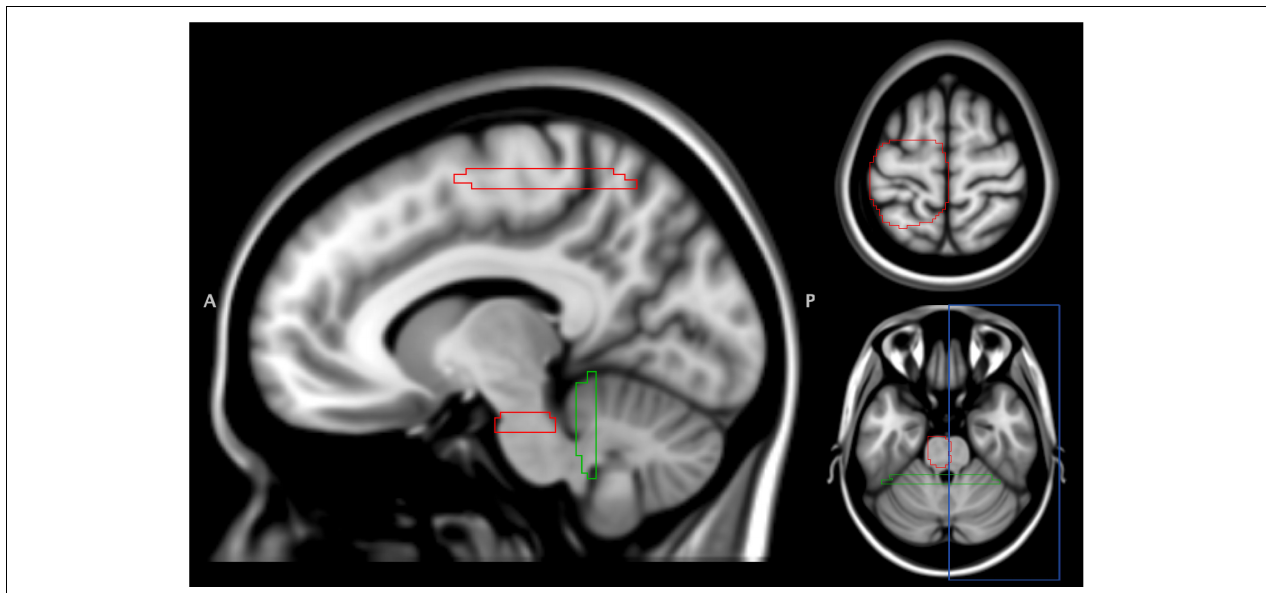
FIGURE 3 | Regions of interest for CST extraction. A total of 4 ROIs were defined in the MNI152 T1 space. Two ROIs (sensorimotor area and brainstem, red) were used for CST extraction. Another two ROIs for excluding streamlines into cerebellum (green) and cross-hemisphere connection (blue). ROI, region of interest; CST, corticospinal